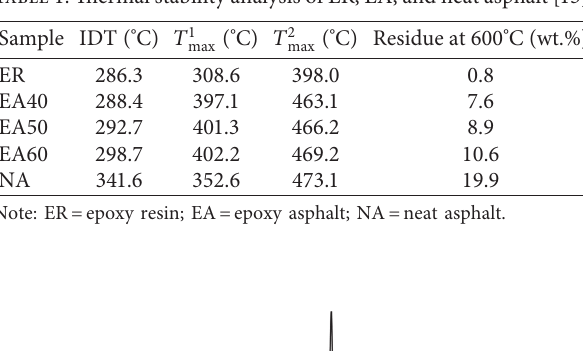
Table 1: Thermal stability analysis of ER, EA, and neat asphalt [15].